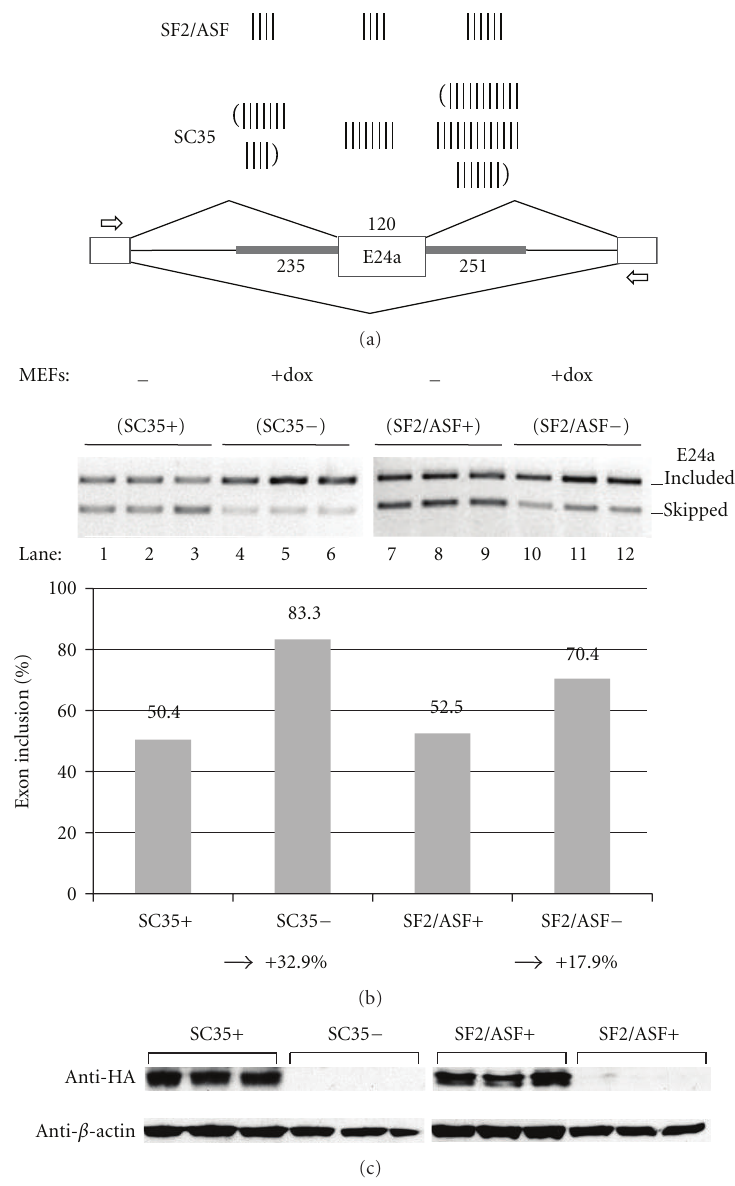
Figure 4: SC35 and ASF/SF2 are negative regulators of CASK E24a. (a) Schematic illustrates the copy number of ASF/SF2 and SC35 motifs in each exon ± ∼ 250 bases of flanking intron. The CASK E24a splicing reporter is shown below with exons represented as boxes and introns as lines. E24a is inserted as the middle exon with flanking intron sequences (thick grey lines); nucleotide lengths for each segment are indicated. Open arrows indicate primer positions in exons 1 and 3 that were used for the amplification of exon included and skipped products. (b) The CASK E24a splicing reporter was transfected into MEF cells engineered with an inducible HA-tagged SC35, or ASF/SF2 expression cassette. Gel panels show splicing patterns after cells were cultured in medium containing Dox, which leads to depletion of SC35 (lanes 4–6) or ASF/SF2 (lanes 10–12). Control cells retain SC35 (lanes 1–3) or ASF/SF2 (lanes 7–9) expression when cultured without Dox. Each lane represents an individual transfection experiment. Graph illustrates the average % exon inclusion values for the gel panels shown. Numbers at bottom of graph indicate net change in splicing pattern (c) Depletion of SC35 and ASF/SF2 were verified by Western blotting with an antibody specific for the HA tag. β -actin, loading